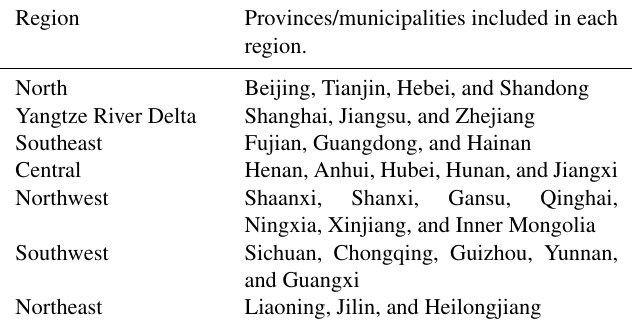
Table A1. Region definitions.